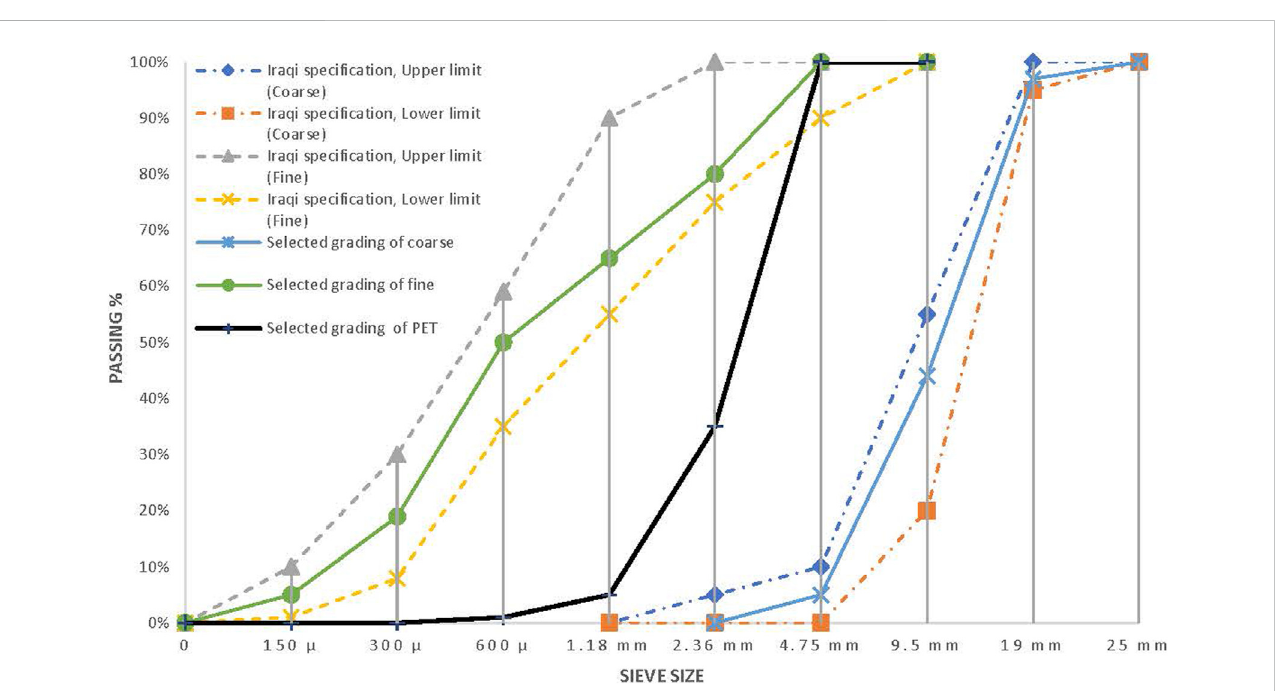
FIGURE 4 Sieve analysis of aggregates.